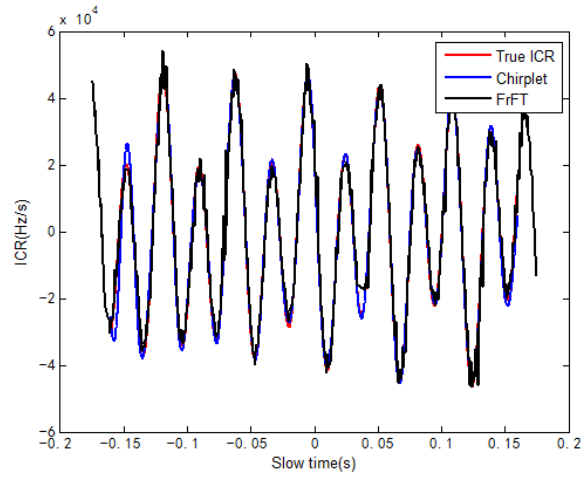
Figure 5. ICR estimation.